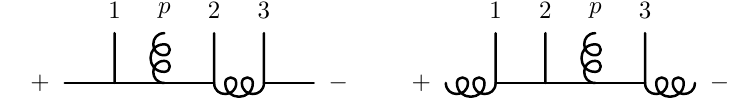
Figure 7 . The forward limits contributing to the integrand in (4.16) are performed in scalars as illustrated in this figure.